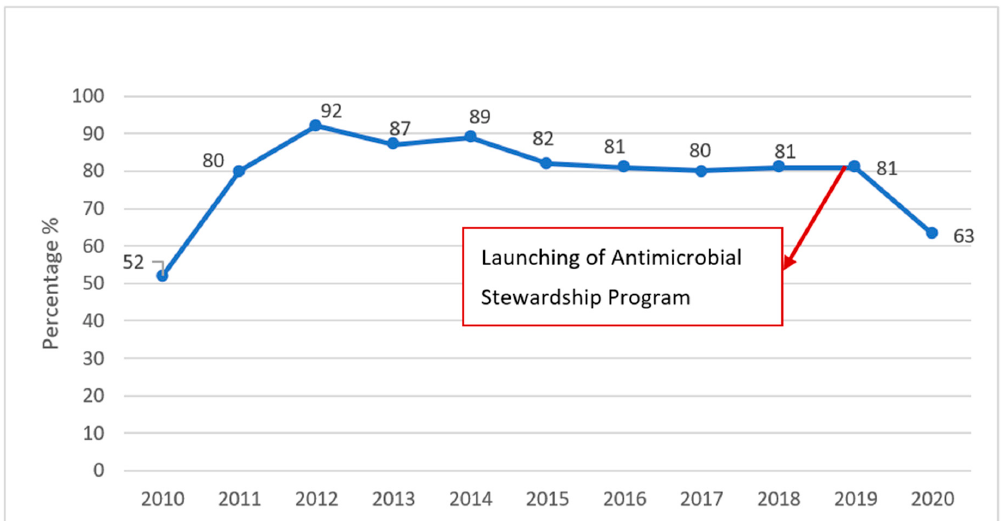
Figure 7. Rates of carbapenem-resistant Acinetobacter baumannii over